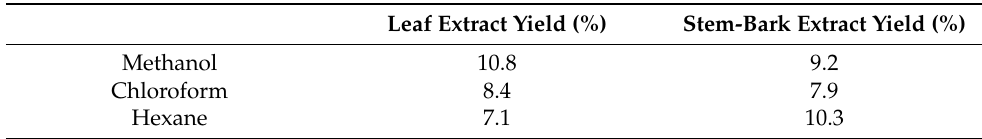
Table 1. Yield of extracts of D. villosa leaves and stem